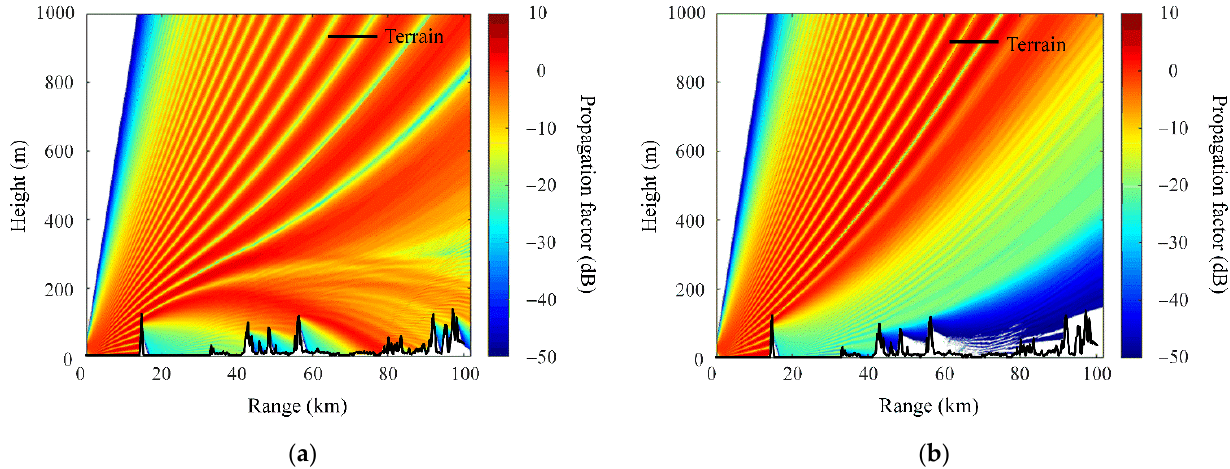
Figure 4. Propagation factor according to different atmospheric conditions in the duct and normal: ( a ) using the measured data of Case 1; ( b ) using the measured data of Case 2. Figure 5 shows the clutter power spectrum according to the atmospheric